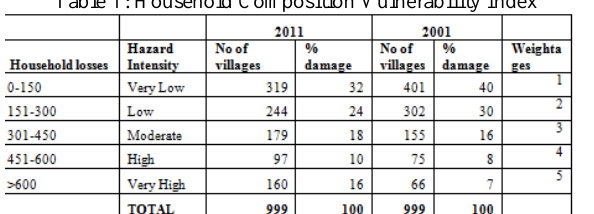
Table 1: Household Composition Vulnerability Index